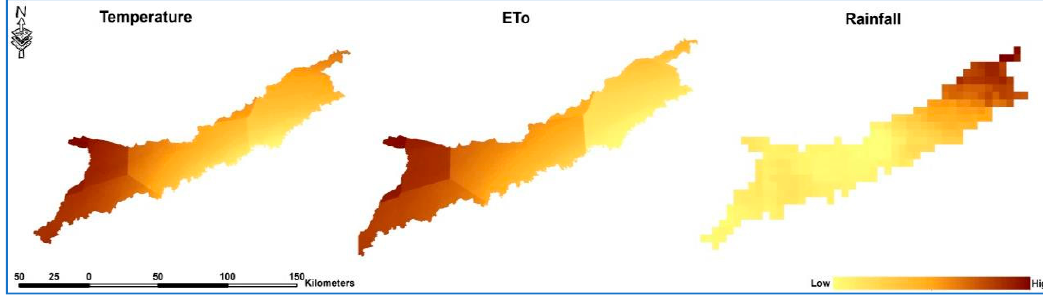
Figure 12. Spatial distribution of meteorological parameters.